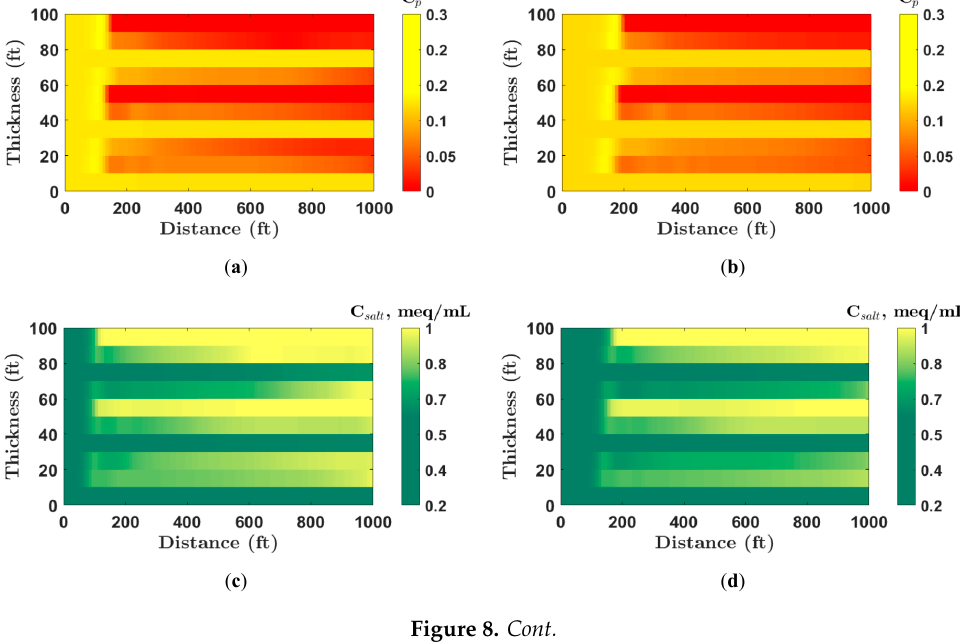
( f ) Figure 8. Polymer concentration ( a , b ), salinity ( c , d ), and aqueous phase viscosity ( e , f ) profiles for the test case using the continuous polymer flooding scheme